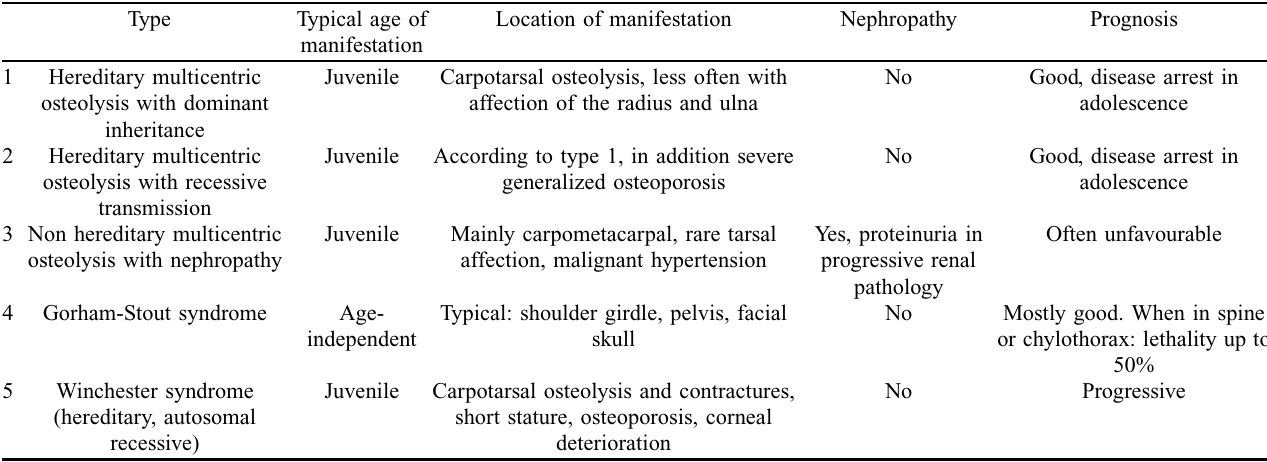
Table 2. Classification of ‘‘Idiopathic osteolysis’’ according to Hardegger et al. [5]. Patients with Gorham-Stout syndrome do not show renal involvement or systemic symptoms.